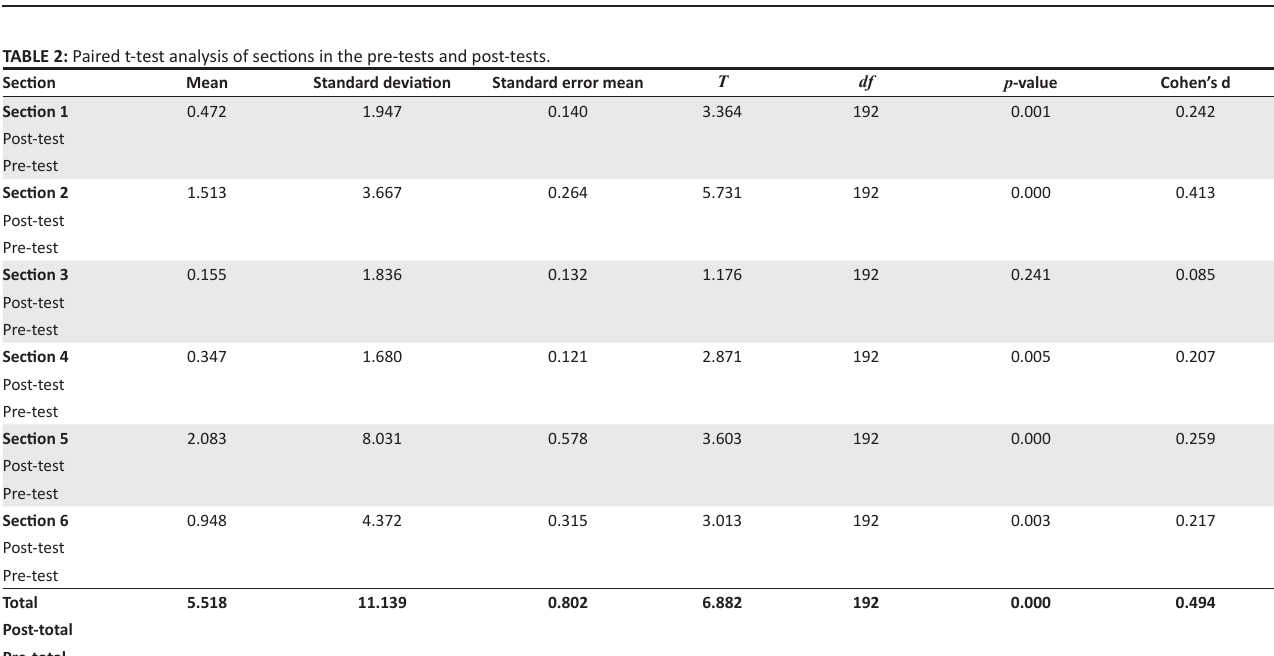
TABLE 2: Paired t-test analysis of sections in the pre-tests and post-tests.